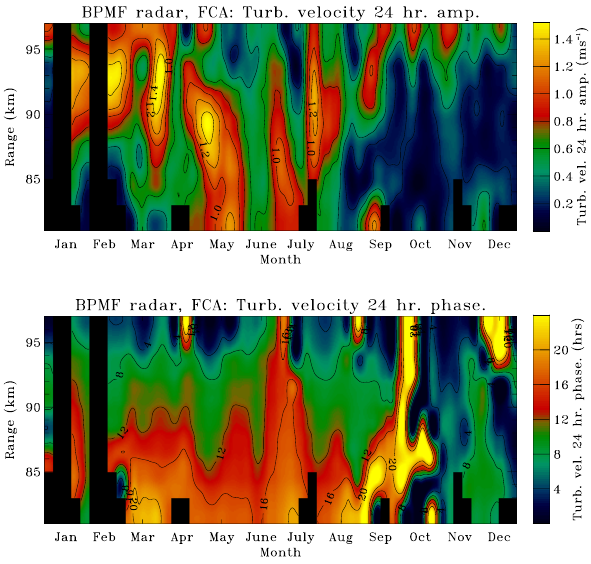
Fig. 8. Power image plot with FCA velocities overlaid for 2nd April Figure8. PowerimageplotwithFCAvelocitiesoverlaidfor2ndApril1997.